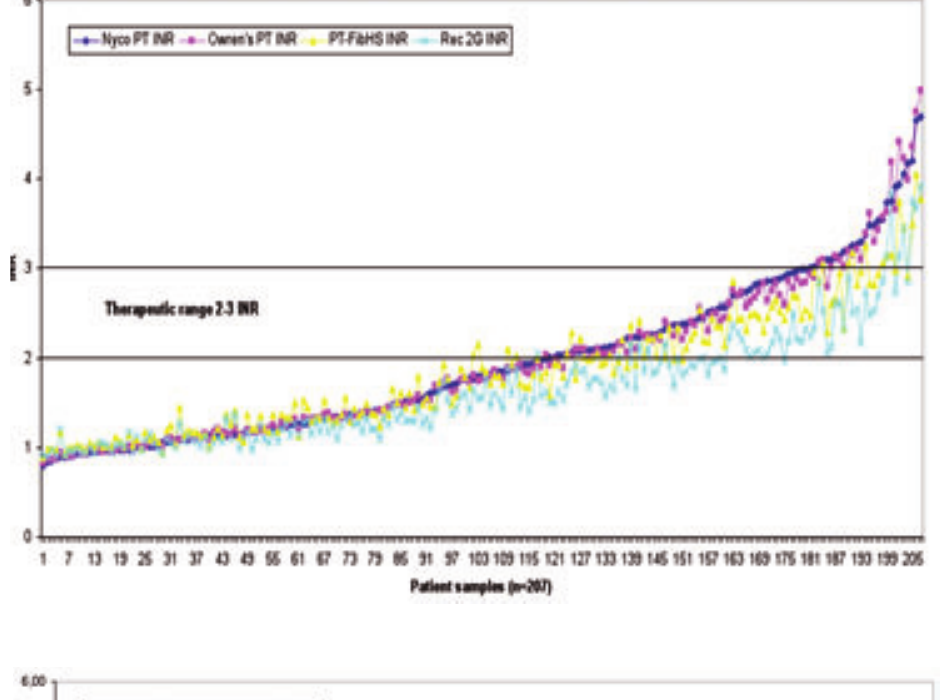
Figure 2. INR TOT and INR ACT values in increasing order from 207 analyzed patient samples on anticoagulation therapy. Owren's PT reagent (com- bined thromboplastin reagent) and the new-generation PT method are used for INR measurement.